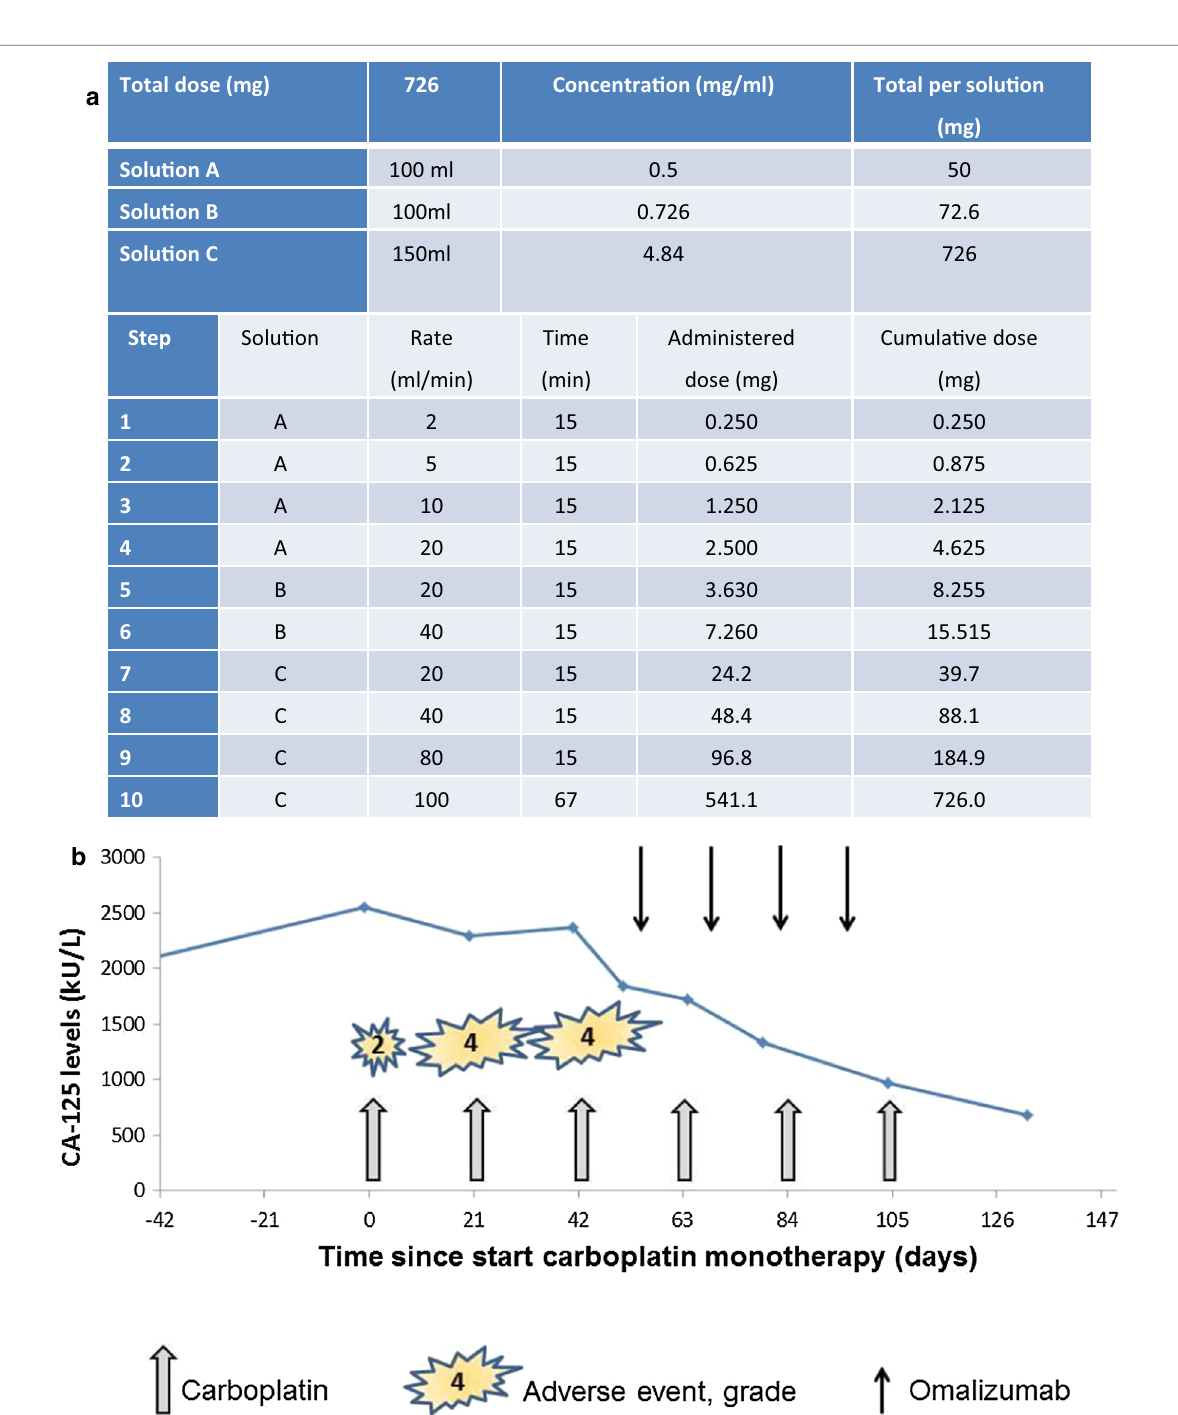
Fig. 1 Management of carboplatin allergy. a 10-step desensitisation schedule for carboplatin. Cumulative dose as administered in the 6th and last cycle of the course. b Overview of carboplatin and omalizumab administration in relation to the adverse allergic